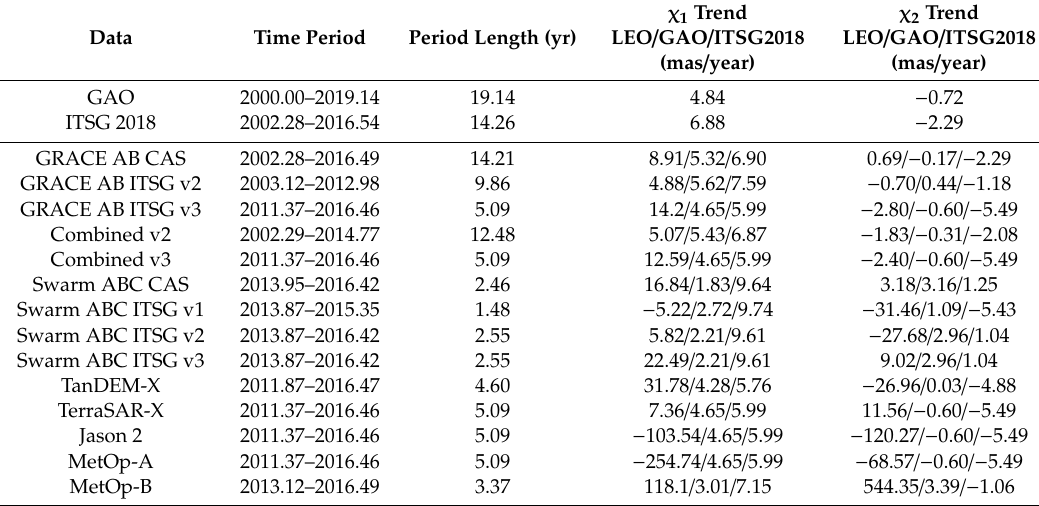
Table 5. Linear trends of χ 1 and χ 2 components of GAO and di ff erent HAM series. Note that series were available in di ff erent time periods (given in decimal years) and with di ff erent period lengths (given in years). The trends of reference series (GAO, ITSG 2018) were computed for all periods of evaluated